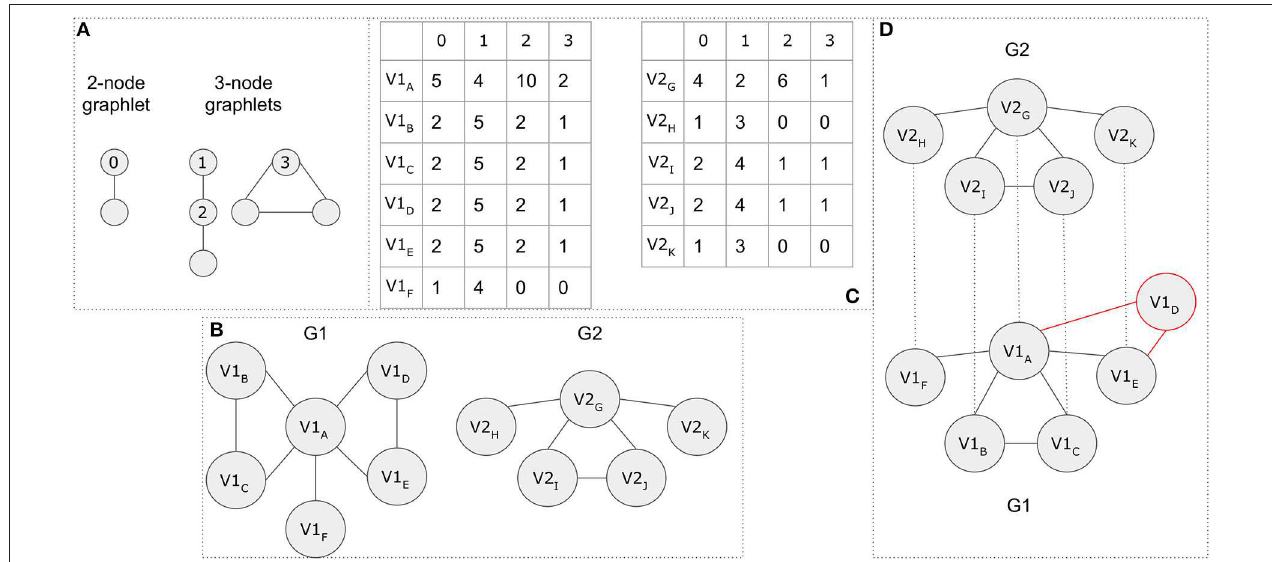
FIGURE 13 | A topology-based network alignment example. (A) Possible graphlet compositions for 2 and 3 nodes. Orbits 0–3, which are annotated, represent the possible position for a node in the various graphlets. (B) G1 and G2 graph representations. (C) Graphlet degree signatures. The row names represent the nodes, while the column names the different orbits. (D) The final network alignment based on a simplified version of the GRAAL algorithm. Node V1 D (in red color) remains unaligned.